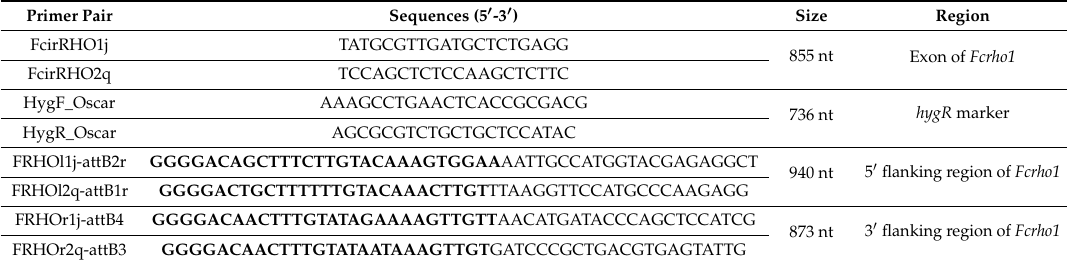
Table 1. Primer pairs used in this study. Flanking regions of the Fcrho1 target gene were amplified using specific primers including att-tails (denoted in bold); nt, nucleotides. Primer Pair Sequences (5 (cid:48) -3 (cid:48) )